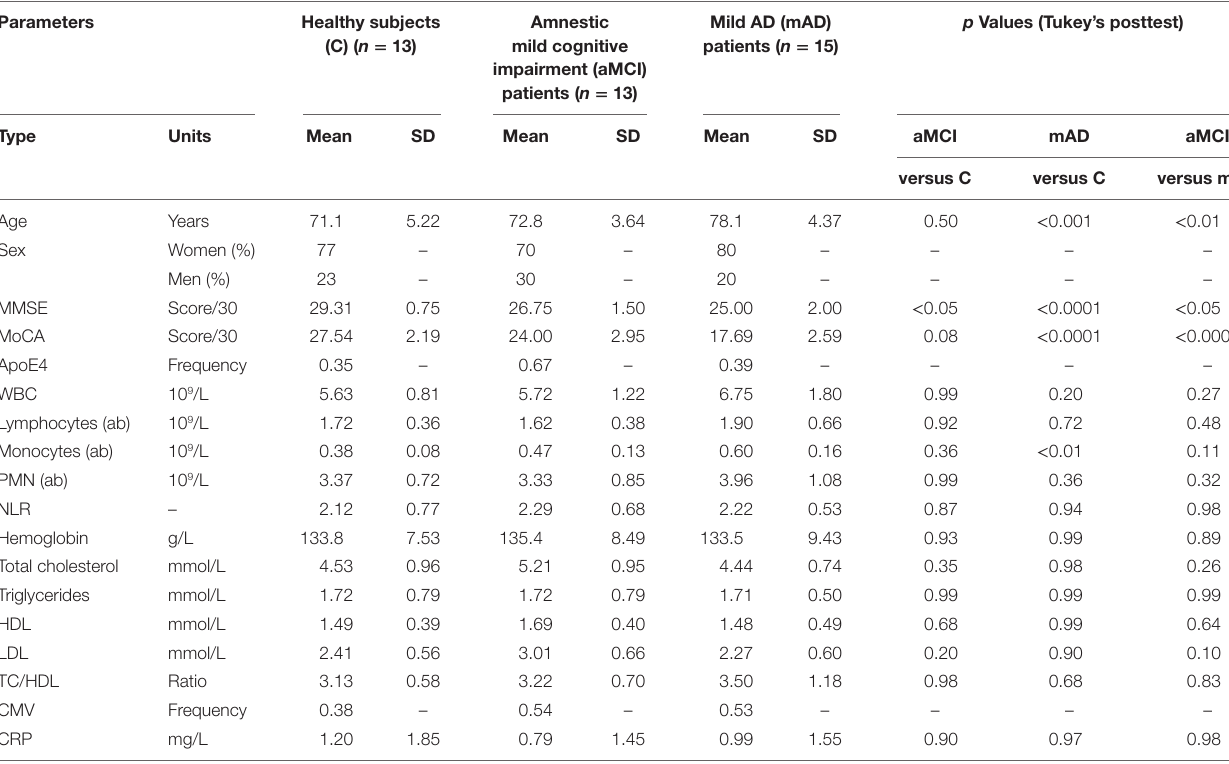
TaBle 1 | Patients’ clinical